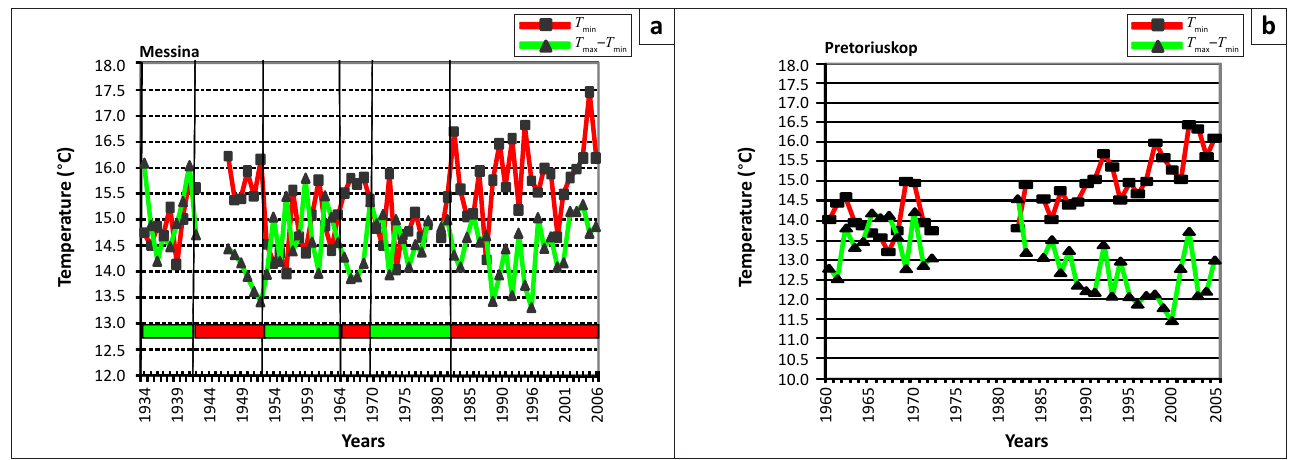
Red rectangles in Figure 7a indicate phases of sustained relatively low diurnal temperature ranges. Green rectangles indicate relatively wide diurnal temperature ranges. FIGURE 7: Annual means of mean monthly minimum temperatures and maximum-minimum temperature differences ( T Messina, northwest of the Kruger National Park and (b) Pretoriuskop (southern KNP at upper altitudes; South African Weather